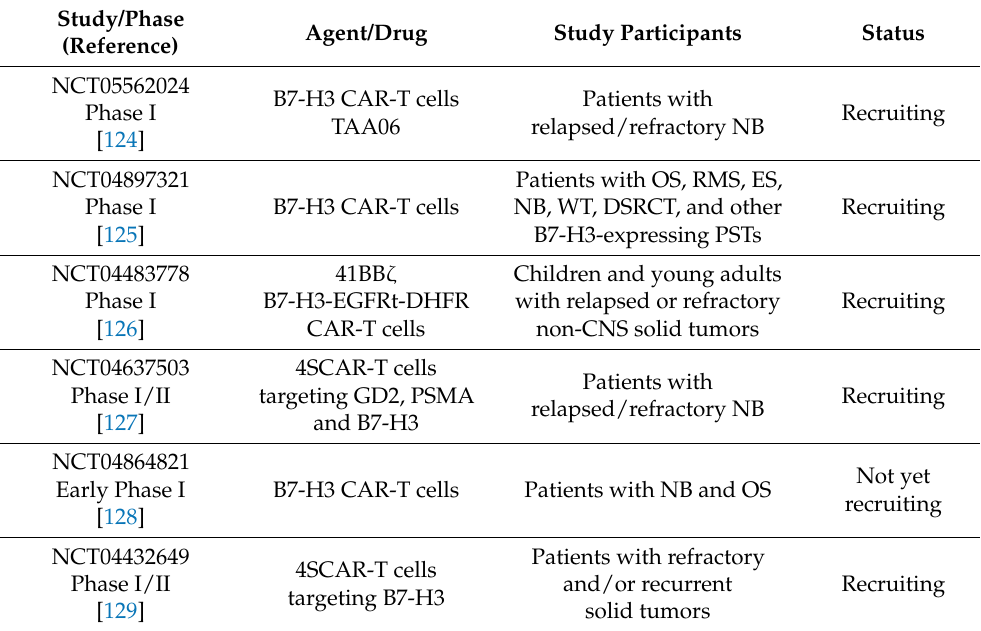
Table 4. B7-H3-targeting CAR-T cells in clinical studies involving PSTs. The table shows the studies on extracranial PSTs as well as the studies involving their metastases in